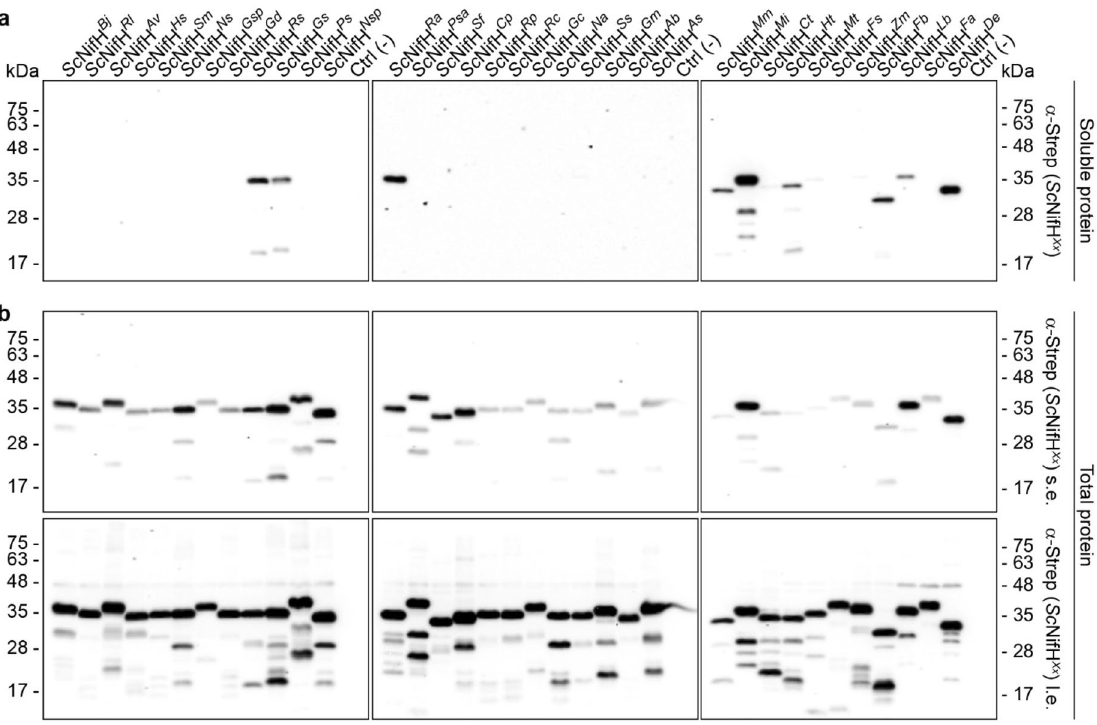
Figure 3. NifH library solubility screening. (a,b) Presence of Sc NifH Xx (see Supplementary Table S2 for full species names) in soluble (a) and total (b) protein extracts was determined using antibodies detecting the TwinStrep-tag (α-Strep). Two different exposure times (s.e., short exposure (above) and l.e., long exposure (below)) are shown for the analysis of total